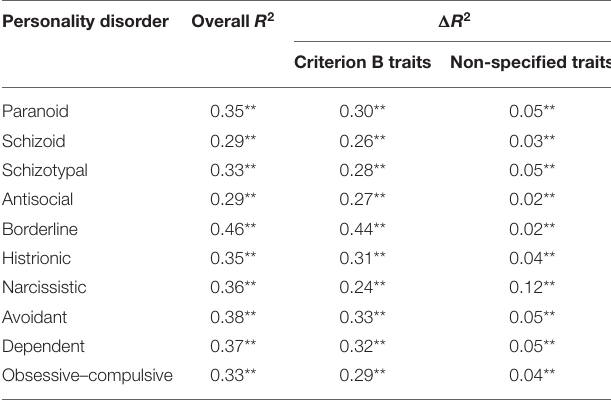
TABLE 6 | Regression analysis results for PID-5 specified and non-specified traits’ predictiveness of SCID-II PD criteria scores in undergraduate sample. Personality disorder Overall R 2 1 R